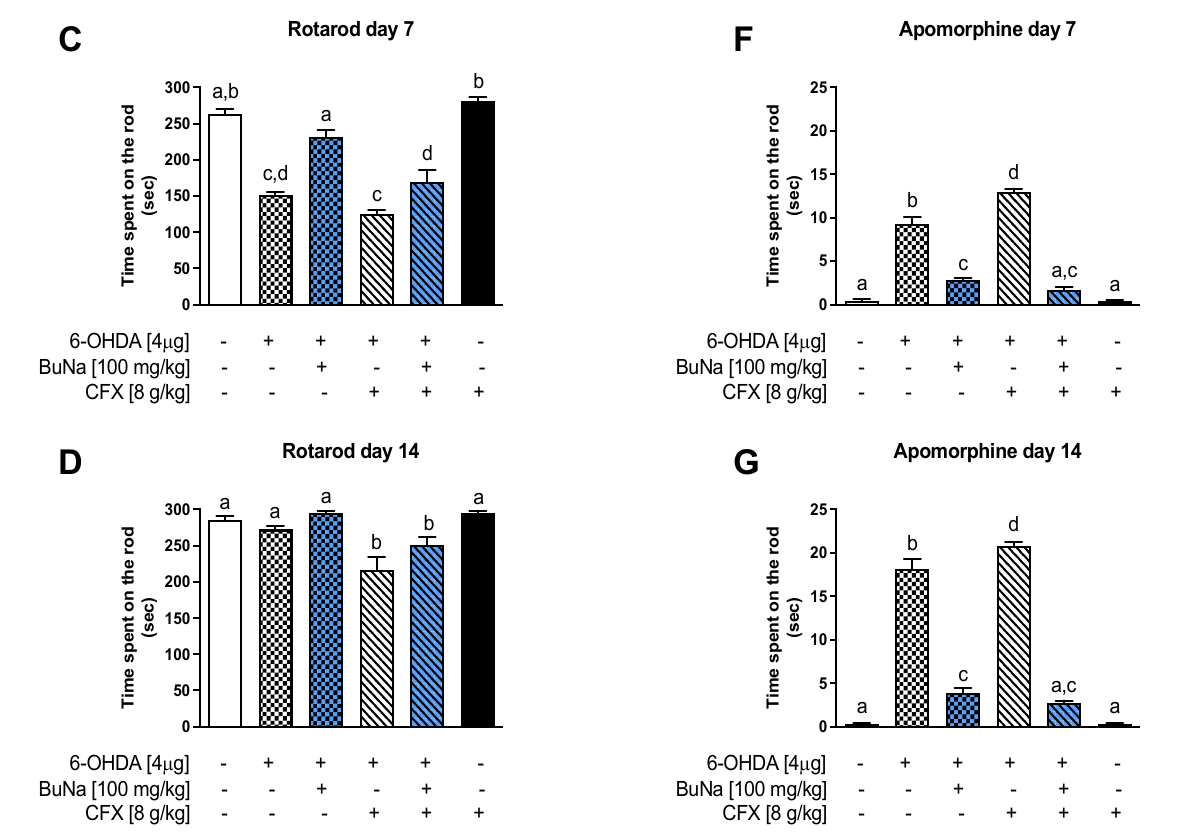
Figure 1. Grouping and schedule ( A ). Effects of BuNa (100 mg/kg) on motor coordination in 6-OHDA-lesioned mice pretreated or not with CFX ( B – D ). CD1 mice were treated with BuNa daily, and time spent on the rod (sec) was assessed and recorded at 3 ( A ), 7 ( C ), and 14 ( D ) days. Values are expressed as mean ± SEM of retention time on the rotating bar. Evaluation of apomorphine-induced rotational behavior ( E – G ). The number of net ipsilateral and contralateral rotations was counted per minute in all animals from all groups after 3 ( E ), 7 ( F ), and 14 ( G ) days. Values are expressed as mean ± SEM ( n = 8–12) of all turns collected during 40 min. Labeled means without a common letter differ, p < 0.05.